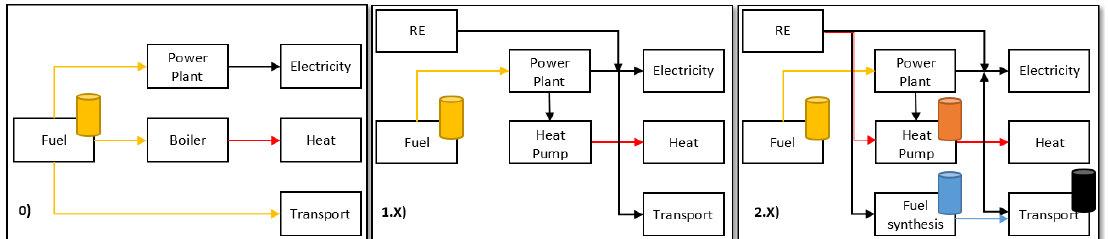
Figure 2. Energy flow diagrams for different energy system and market relation setups based on Scenarios 0 , 1.X and 2.X , simplified, based on [36] (barrels indicating storage options).